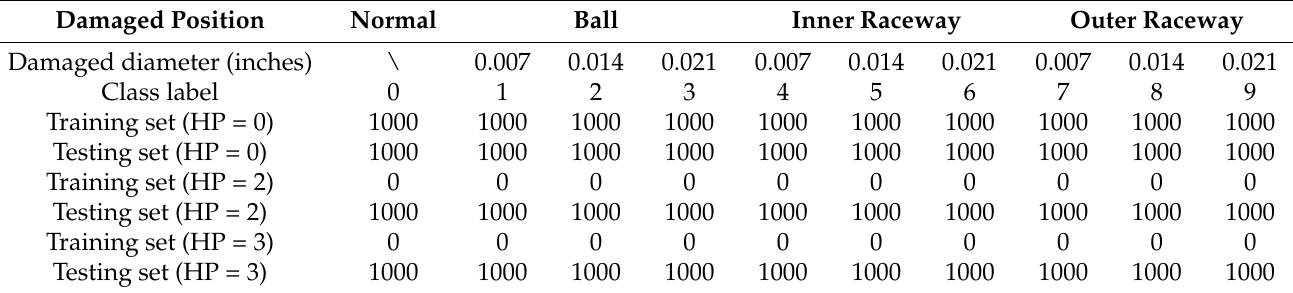
Figure 3. The test platform. Table 2. Description of data